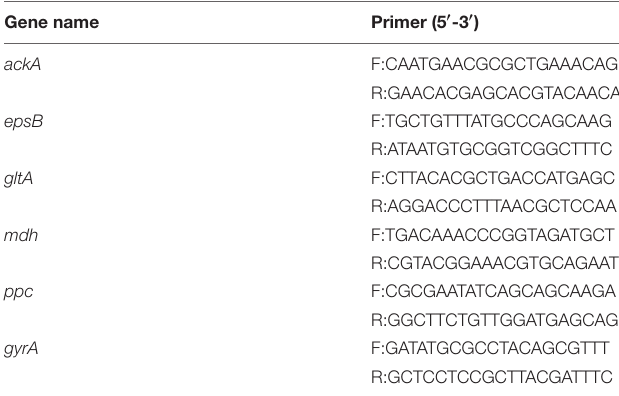
TABLE 1 | Specific primers for qRT-PCR of Bacillus aryabhattai SK1-7 solubilization-related genes. Gene name Primer (5 (cid:48) -3 (cid:48)